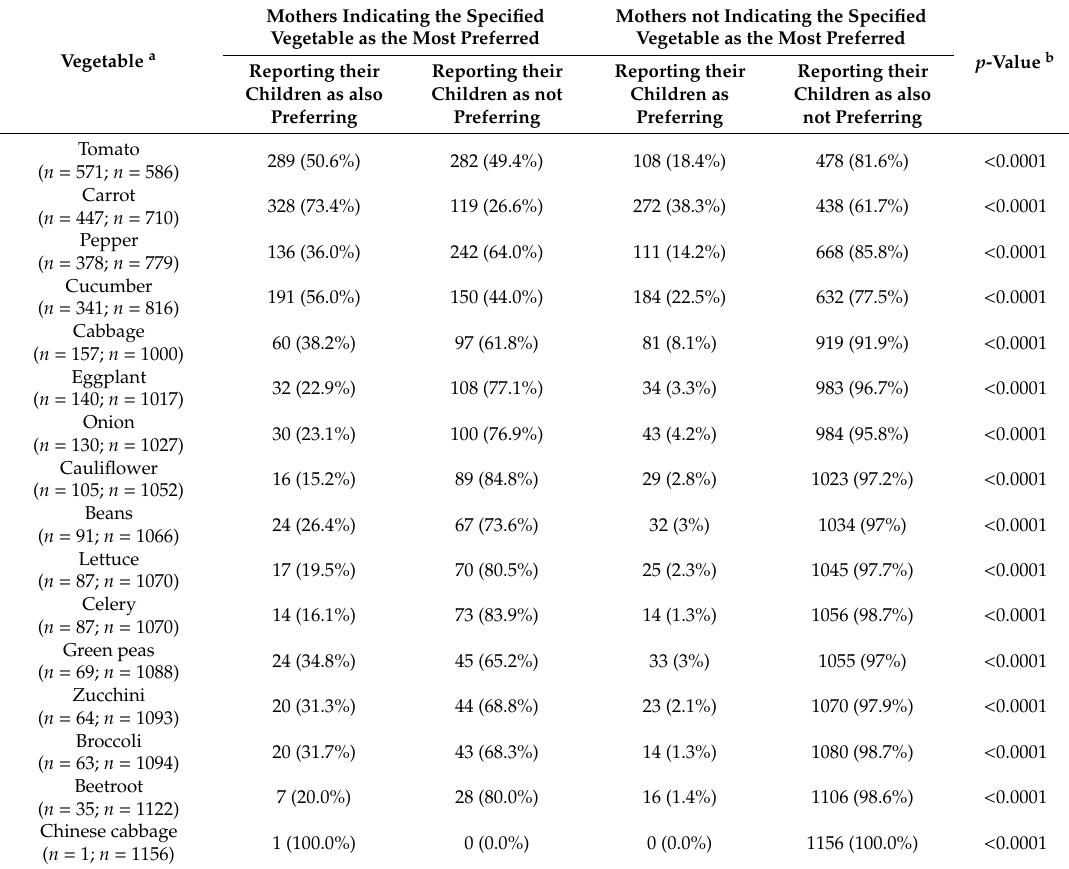
Table 6. Analysis of the association between the vegetable preferences self-reported by the mothers and reported by them for their children in a nationally representative sample of Romanian mother–child pairs ( n =